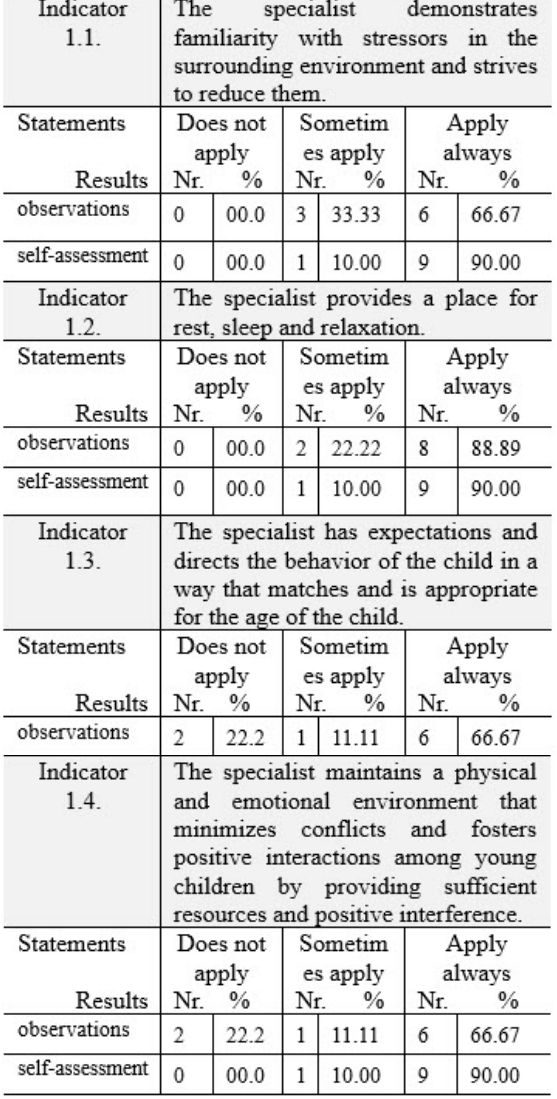
Table 26. Principle 1: The environment encourages the emotional well-being of each child.